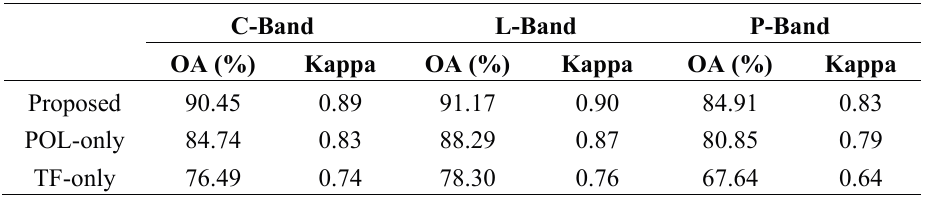
Table 6. Accuracies for classification with full features (proposed), polarimetric features (POL-only) and TF features (TF-only) of the three